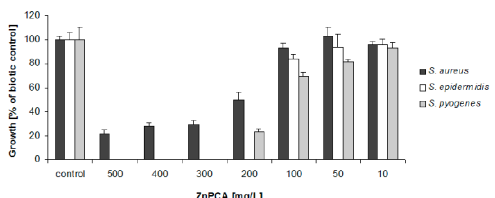
Figure 5. The antibacterial properties of zinc(II)-amino acid complexes ( 1 – 6 ) and the ZnPCA reference compound.